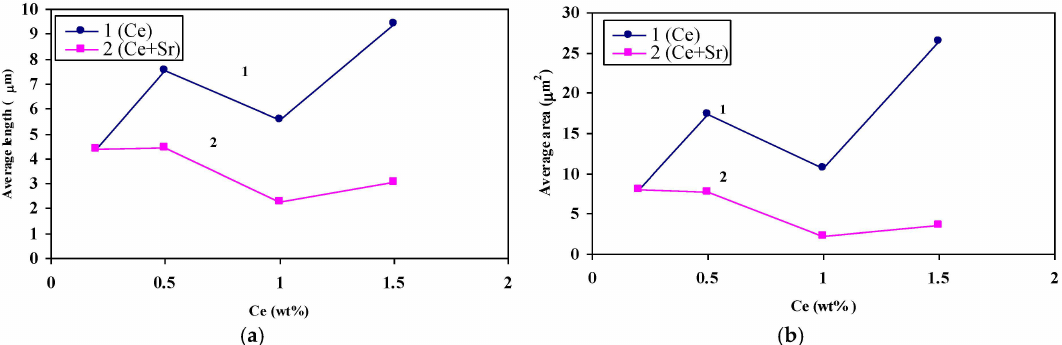
Figure 13. ( a ) The effect of Ce and Sr on the average of Si particle length; ( b ) the effect of Ce and Sr on the average of Si particle area.